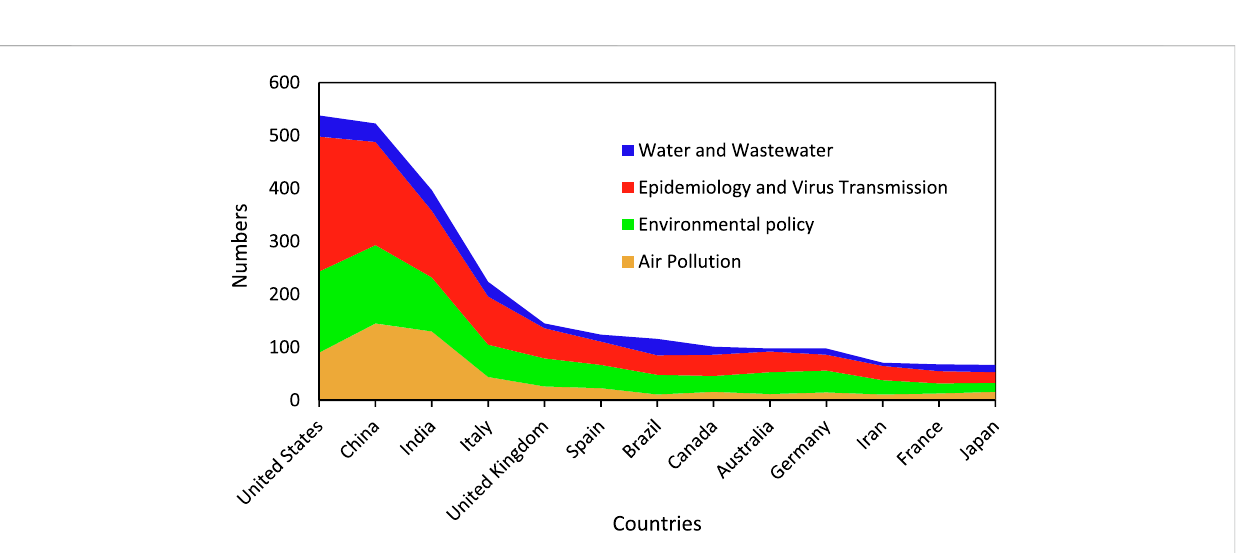
FIGURE 4 Papers published according to the clusters based on countries. The highest number of papers were published in the United States, followed by China, India, and Italy. The next countries are the United Kingdom, Spain, Brazil, and Canada. The air pollution cluster has the most published papers in China, while epidemiology and virus transmission attracted more scientists from the United